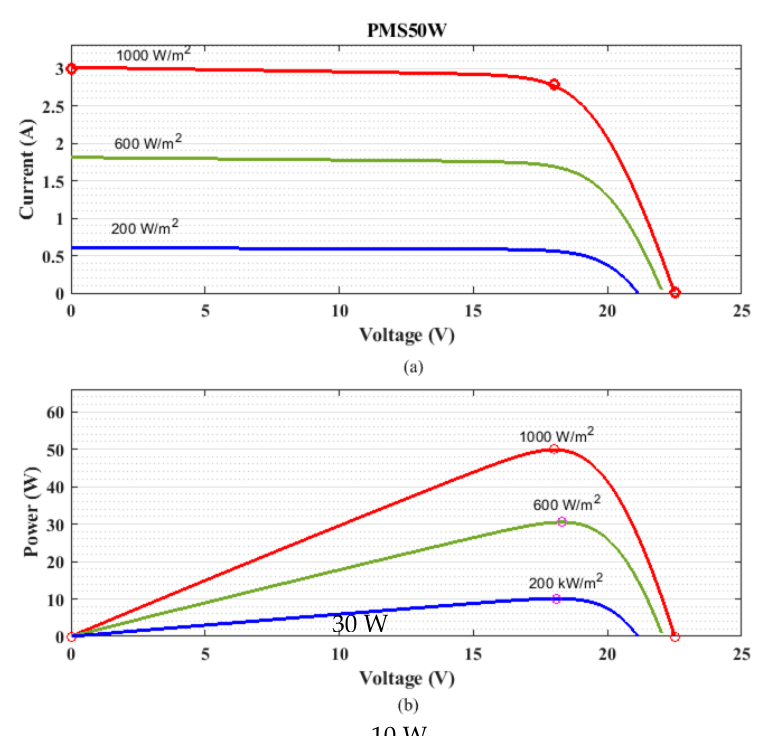
Figure 7. ( a ) I-V and ( b ) P-V curves of PMS50W at high (1000 W/m 2 ), medium (600 W/m 2 ), and low (200 W/m 2 ) irradiances.